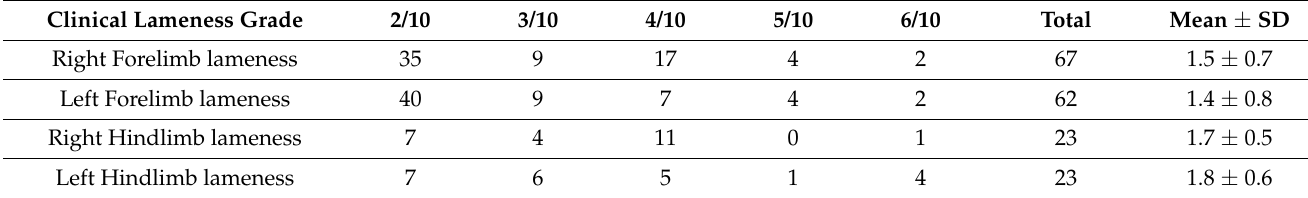
Table 1. Number of horses showing a lameness depending on the location and the grade according to the 11-grades UK lameness scale. Mean ± SD 1 of lameness grade in each lame horses group. Clinical Lameness Grade 2/10 3/10 4/10 5/10 Total Mean ± SD Right Forelimb lameness 35 Left Forelimb lameness 40 Right Hindlimb lameness Left Hindlimb